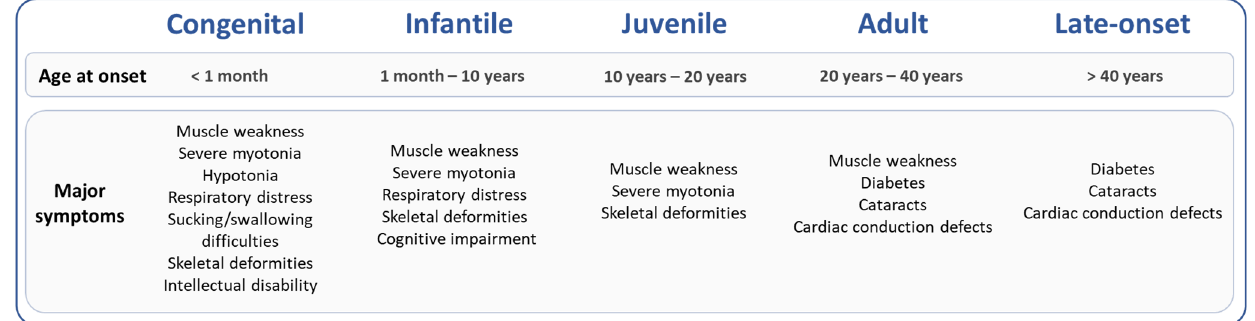
Figure 1. DM1 clinical classification: five forms and their main symptoms [4].